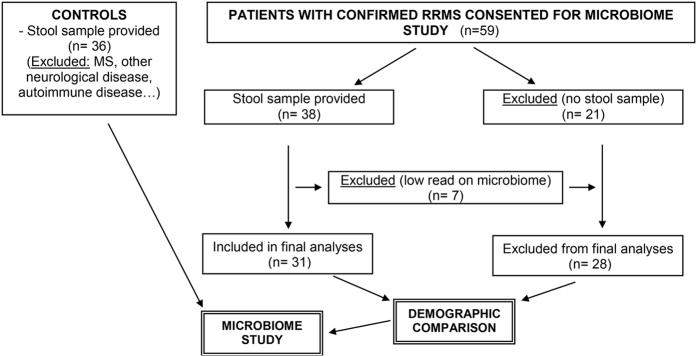
Flowchart explaining RRMS patients and controls recruited for the study with exclusion and inclusion criteria.